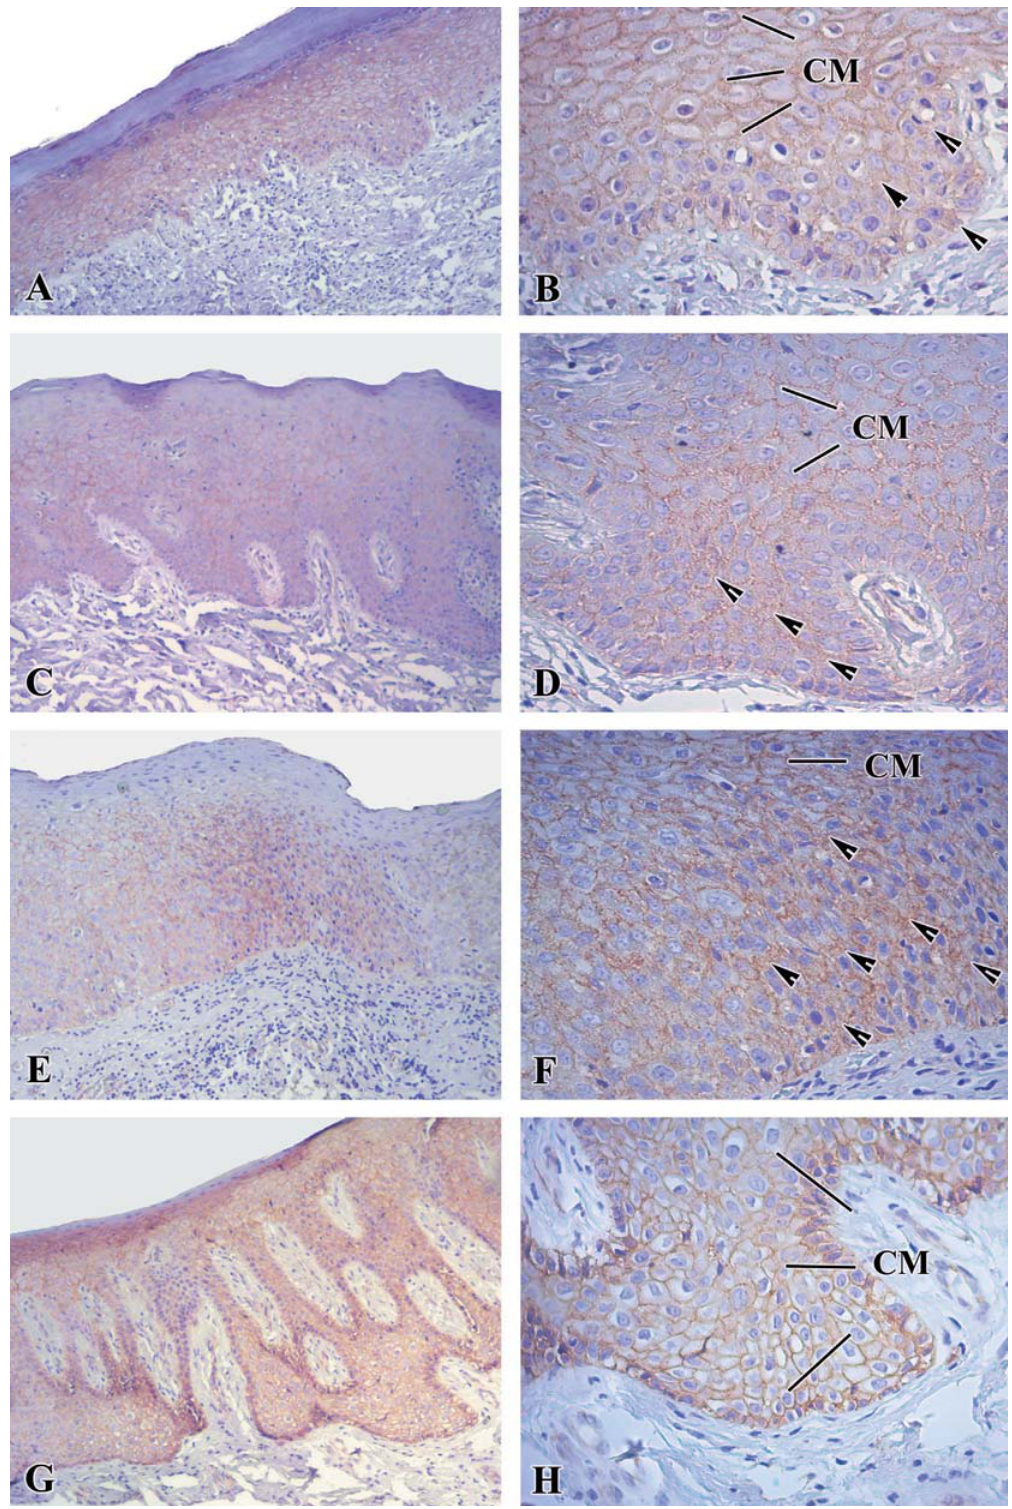
Figure 2- (cid:3)(cid:533)(cid:16)(cid:70)(cid:68)(cid:87)(cid:72)(cid:81)(cid:76)(cid:81)(cid:3)(cid:76)(cid:80)(cid:80)(cid:88)(cid:81)(cid:82)(cid:75)(cid:76)(cid:86)(cid:87)(cid:82)(cid:70)(cid:75)(cid:72)(cid:80)(cid:76)(cid:70)(cid:68)(cid:79)(cid:3)(cid:72)(cid:91)(cid:83)(cid:85)(cid:72)(cid:86)(cid:86)(cid:76)(cid:82)(cid:81)(cid:3)(cid:76)(cid:81)(cid:3)(cid:82)(cid:85)(cid:68)(cid:79)(cid:3)(cid:79)(cid:72)(cid:88)(cid:78)(cid:82)(cid:83)(cid:79)(cid:68)(cid:78)(cid:76)(cid:68)(cid:3)(cid:11)(cid:50)(cid:47)(cid:12)(cid:3)(cid:11)(cid:80)(cid:76)(cid:79)(cid:71)(cid:15)(cid:3)(cid:80)(cid:82)(cid:71)(cid:72)(cid:85)(cid:68)(cid:87)(cid:72)(cid:3)(cid:68)(cid:81)(cid:71)(cid:3)(cid:86)(cid:72)(cid:89)(cid:72)(cid:85)(cid:72)(cid:3)(cid:71)(cid:92)(cid:86)(cid:83)(cid:79)(cid:68)(cid:86)(cid:76)(cid:68)(cid:12)(cid:3)(cid:68)(cid:81)(cid:71)(cid:3) (cid:81)(cid:82)(cid:85)(cid:80)(cid:68)(cid:79)(cid:3)(cid:82)(cid:85)(cid:68)(cid:79)(cid:3)(cid:80)(cid:88)(cid:70)(cid:82)(cid:86)(cid:68)(cid:17)(cid:3)(cid:11)(cid:36)(cid:12)(cid:3)(cid:533)(cid:16)(cid:70)(cid:68)(cid:87)(cid:72)(cid:81)(cid:76)(cid:81)(cid:3)(cid:70)(cid:92)(cid:87)(cid:82)(cid:83)(cid:79)(cid:68)(cid:86)(cid:80)(cid:76)(cid:70)(cid:3)(cid:80)(cid:72)(cid:80)(cid:69)(cid:85)(cid:68)(cid:81)(cid:72)(cid:3)(cid:86)(cid:87)(cid:68)(cid:76)(cid:81)(cid:76)(cid:81)(cid:74)(cid:15)(cid:3)(cid:76)(cid:81)(cid:3)(cid:68)(cid:79)(cid:79)(cid:3)(cid:87)(cid:75)(cid:85)(cid:72)(cid:72)(cid:3)(cid:79)(cid:68)(cid:92)(cid:72)(cid:85)(cid:86)(cid:3)(cid:82)(cid:73)(cid:3)(cid:80)(cid:76)(cid:79)(cid:71)(cid:3)(cid:71)(cid:92)(cid:86)(cid:83)(cid:79)(cid:68)(cid:86)(cid:76)(cid:68)(cid:3)(cid:11)(cid:91)(cid:20)(cid:19)(cid:19)(cid:12)(cid:15)(cid:3)(cid:68)(cid:81)(cid:71)(cid:3)(cid:11)(cid:37)(cid:12)(cid:3)(cid:76)(cid:81)(cid:3) (cid:87)(cid:75)(cid:72)(cid:3)(cid:70)(cid:92)(cid:87)(cid:82)(cid:83)(cid:79)(cid:68)(cid:86)(cid:80)(cid:3)(cid:82)(cid:73)(cid:3)(cid:69)(cid:68)(cid:86)(cid:68)(cid:79)(cid:3)(cid:68)(cid:81)(cid:71)(cid:3)(cid:83)(cid:68)(cid:85)(cid:68)(cid:69)(cid:68)(cid:86)(cid:68)(cid:79)(cid:3)(cid:70)(cid:72)(cid:79)(cid:79)(cid:86)(cid:17)(cid:3)(cid:11)(cid:38)(cid:15)(cid:3)(cid:39)(cid:12)(cid:3)(cid:44)(cid:79)(cid:79)(cid:88)(cid:86)(cid:87)(cid:85)(cid:68)(cid:87)(cid:76)(cid:82)(cid:81)(cid:86)(cid:3)(cid:82)(cid:73)(cid:3)(cid:87)(cid:75)(cid:72)(cid:3)(cid:533)(cid:16)(cid:70)(cid:68)(cid:87)(cid:72)(cid:81)(cid:76)(cid:81)(cid:3)(cid:70)(cid:92)(cid:87)(cid:82)(cid:83)(cid:79)(cid:68)(cid:86)(cid:80)(cid:76)(cid:70)(cid:3)(cid:80)(cid:72)(cid:80)(cid:69)(cid:85)(cid:68)(cid:81)(cid:72)(cid:3)(cid:11)(cid:38)(cid:48)(cid:12)(cid:3)(cid:72)(cid:91)(cid:83)(cid:85)(cid:72)(cid:86)(cid:86)(cid:76)(cid:82)(cid:81)(cid:3) in the upper layers of moderate dysplasia, showing a decrease in cytoplasmic membrane expression, with more evident cytoplasmic localization in basal and parabasal cells (arrows head) (x100 - x400). (E, F) Weak membranous expression of (cid:533)(cid:16)(cid:70)(cid:68)(cid:87)(cid:72)(cid:81)(cid:76)(cid:81)(cid:3)(cid:76)(cid:81)(cid:3)(cid:83)(cid:68)(cid:85)(cid:68)(cid:69)(cid:68)(cid:86)(cid:68)(cid:79)(cid:3)(cid:68)(cid:81)(cid:71)(cid:3)(cid:69)(cid:68)(cid:86)(cid:68)(cid:79)(cid:3)(cid:79)(cid:68)(cid:92)(cid:72)(cid:85)(cid:86)(cid:3)(cid:82)(cid:73)(cid:3)(cid:86)(cid:72)(cid:89)(cid:72)(cid:85)(cid:72)(cid:3)(cid:71)(cid:92)(cid:86)(cid:83)(cid:79)(cid:68)(cid:86)(cid:76)(cid:68)(cid:15)(cid:3)(cid:90)(cid:76)(cid:87)(cid:75)(cid:3)(cid:68)(cid:3)(cid:86)(cid:76)(cid:74)(cid:81)(cid:76)(cid:191)(cid:70)(cid:68)(cid:81)(cid:87)(cid:3)(cid:76)(cid:81)(cid:70)(cid:85)(cid:72)(cid:68)(cid:86)(cid:72)(cid:3)(cid:76)(cid:81)(cid:3)(cid:76)(cid:87)(cid:86)(cid:3)(cid:72)(cid:91)(cid:83)(cid:85)(cid:72)(cid:86)(cid:86)(cid:76)(cid:82)(cid:81)(cid:15)(cid:3)(cid:76)(cid:81)(cid:3)(cid:87)(cid:75)(cid:72)(cid:3)(cid:70)(cid:92)(cid:87)(cid:82)(cid:83)(cid:79)(cid:68)(cid:86)(cid:80)(cid:3) (cid:11)(cid:68)(cid:85)(cid:85)(cid:82)(cid:90)(cid:86)(cid:3)(cid:75)(cid:72)(cid:68)(cid:71)(cid:12)(cid:3)(cid:82)(cid:73)(cid:3)(cid:70)(cid:72)(cid:79)(cid:79)(cid:86)(cid:3)(cid:82)(cid:73)(cid:3)(cid:69)(cid:68)(cid:86)(cid:68)(cid:79)(cid:82)(cid:76)(cid:71)(cid:3)(cid:68)(cid:83)(cid:83)(cid:72)(cid:68)(cid:85)(cid:68)(cid:81)(cid:70)(cid:72)(cid:3)(cid:11)(cid:91)(cid:20)(cid:19)(cid:19)(cid:3)(cid:16)(cid:3)(cid:91)(cid:23)(cid:19)(cid:19)(cid:12)(cid:17)(cid:3)(cid:11)(cid:42)(cid:15)(cid:3)(cid:43)(cid:12)(cid:3)(cid:533)(cid:16)(cid:70)(cid:68)(cid:87)(cid:72)(cid:81)(cid:76)(cid:81)(cid:3)(cid:76)(cid:81)(cid:3)(cid:81)(cid:82)(cid:85)(cid:80)(cid:68)(cid:79)(cid:3)(cid:82)(cid:85)(cid:68)(cid:79)(cid:3)(cid:80)(cid:88)(cid:70)(cid:82)(cid:86)(cid:68)(cid:3)(cid:11)(cid:91)(cid:20)(cid:19)(cid:19)(cid:3)(cid:16)(cid:3)(cid:91)(cid:23)(cid:19)(cid:19)(cid:12)